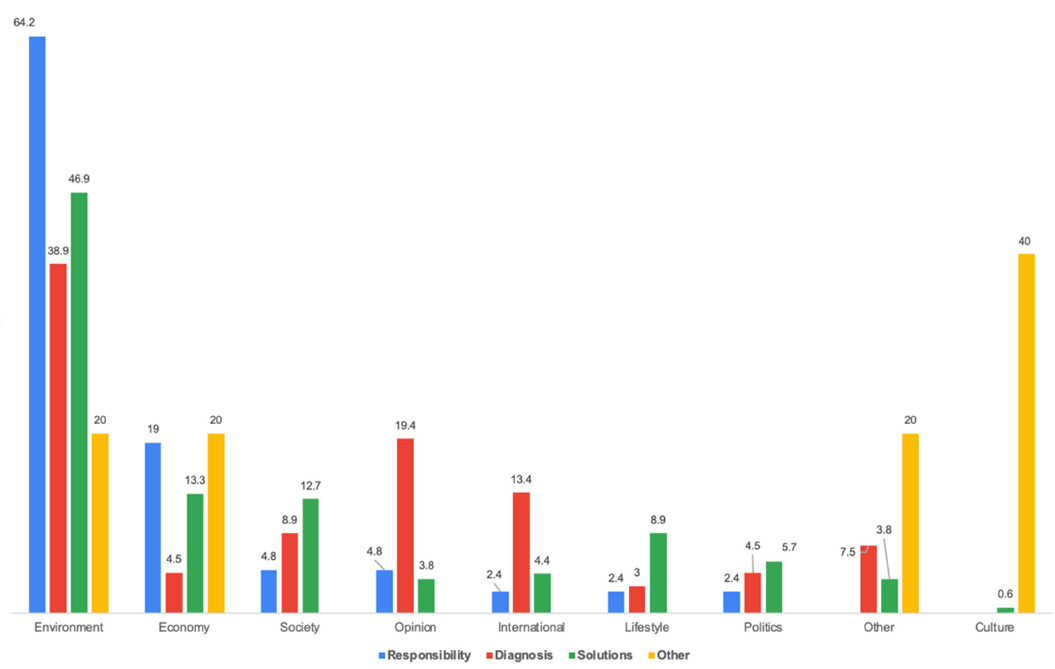
Figure 6. Percentage of items published by frame in each section of the sample (%).